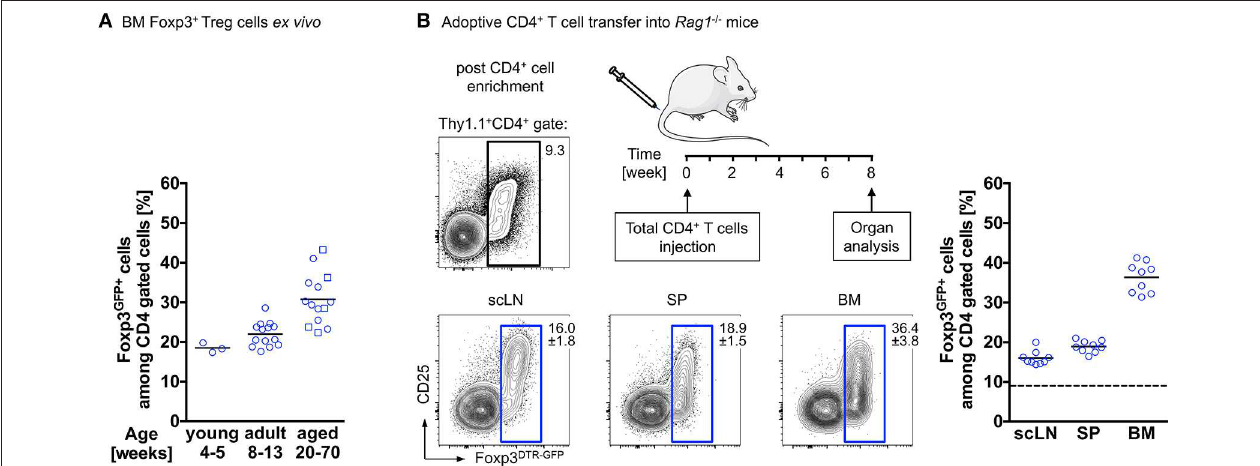
FIGURE 1 | Accumulation of Foxp3 + Treg cells in the BM. (A) Age-related accumulation of BM-resident Foxp3 + Treg cells. Flow cytometry analysis of Foxp3 GFP + cells within the CD4 + T cell population in the BM of wildtype mice of different age groups. Each experiment was performed with at least 3 mice and symbols and lines indicate individual mice and mean values, respectively (young: 4–5 weeks; adult: 8–13 weeks; aged: circles: 20–22 weeks; and squares: 50–70 weeks). (B) Schematic overview of the experimental design. Four-week-old Rag1 − / − mice were adoptively transferred with bulk CD4 + T cells (upper plot: Foxp3 + Treg cell proportion among total CD4 + T cells before adoptively transferred). The distributions of gated Foxp3 DTR − GFP + cells in various organs of the recipient mice (scLN, subcutaneous lymph nodes; SP, spleen, and BM, bone marrow) were analyzed by flow cytometry 8 weeks after transfer. Numbers in plots indicate the mean percentages ± SD of gated cells within the respective gate. Graph illustrates the accumulation of Foxp3 + Treg cells in the BM. Data are collected from two independent experiments with 4–5 mice; symbols and lines denote individual mice and mean values,